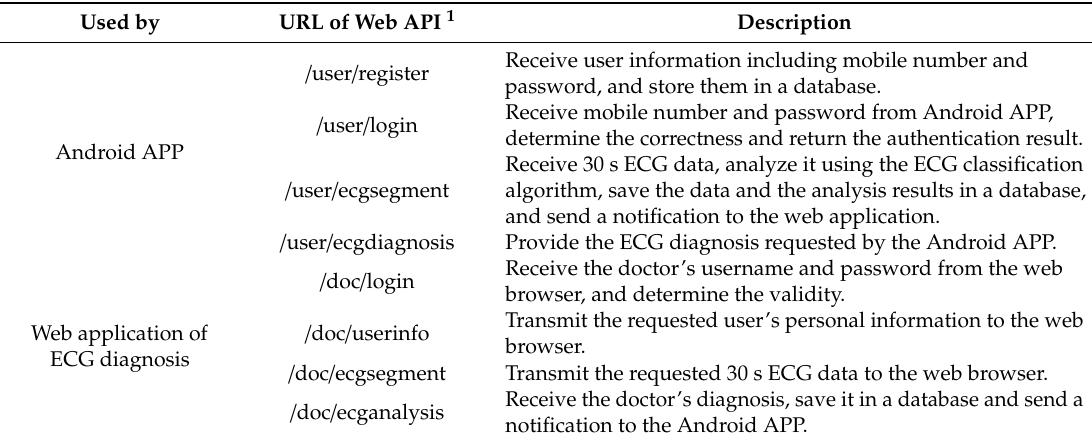
Table 5. Descriptions of the web APIs.